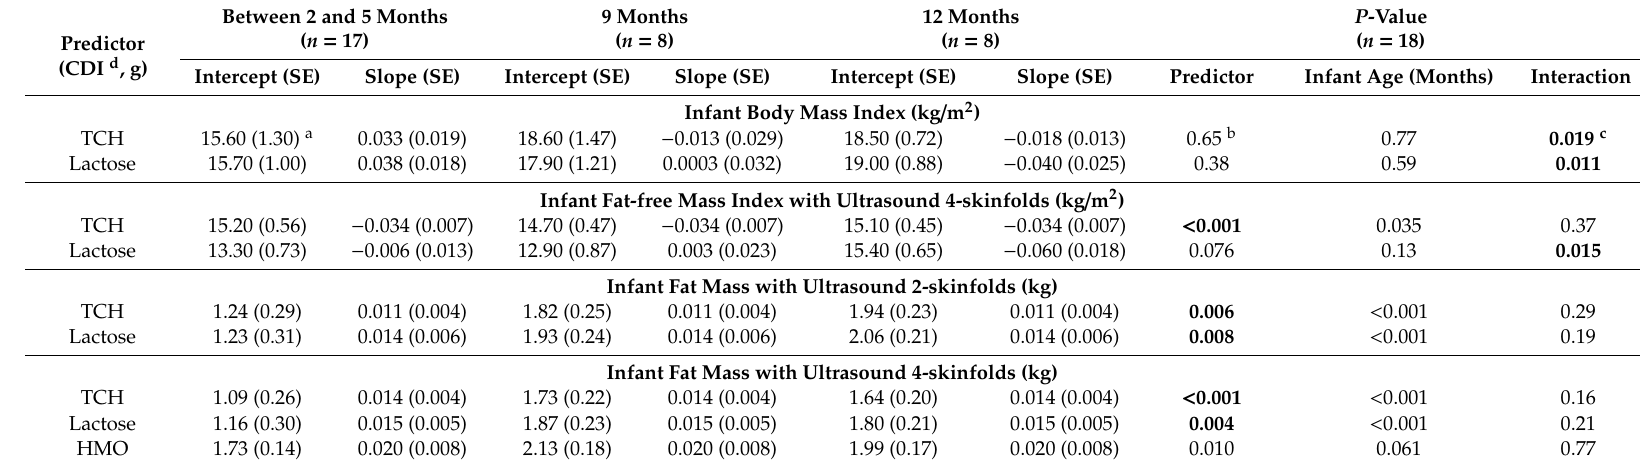
Table 4. Associations between calculated daily intakes of human milk carbohydrates and infant